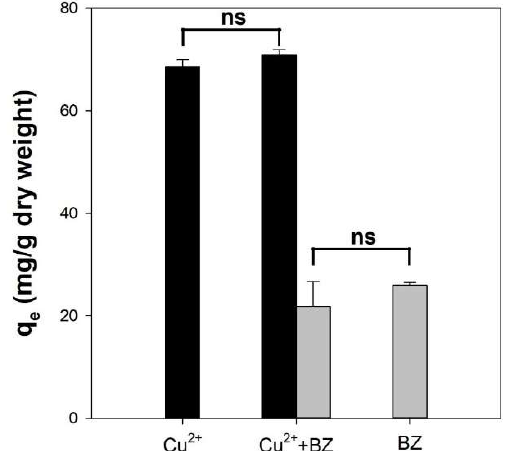
Figure 7. Comparison of the adsorption capacities of single contaminant Cu 2+ (black bar) or benzene (gray bar) and contaminant mixture (Cu 2+ and benzene) solution onto alginate/biochar hydrogel beads (4% alginate/4% biochar). t -test; ns: not significant.